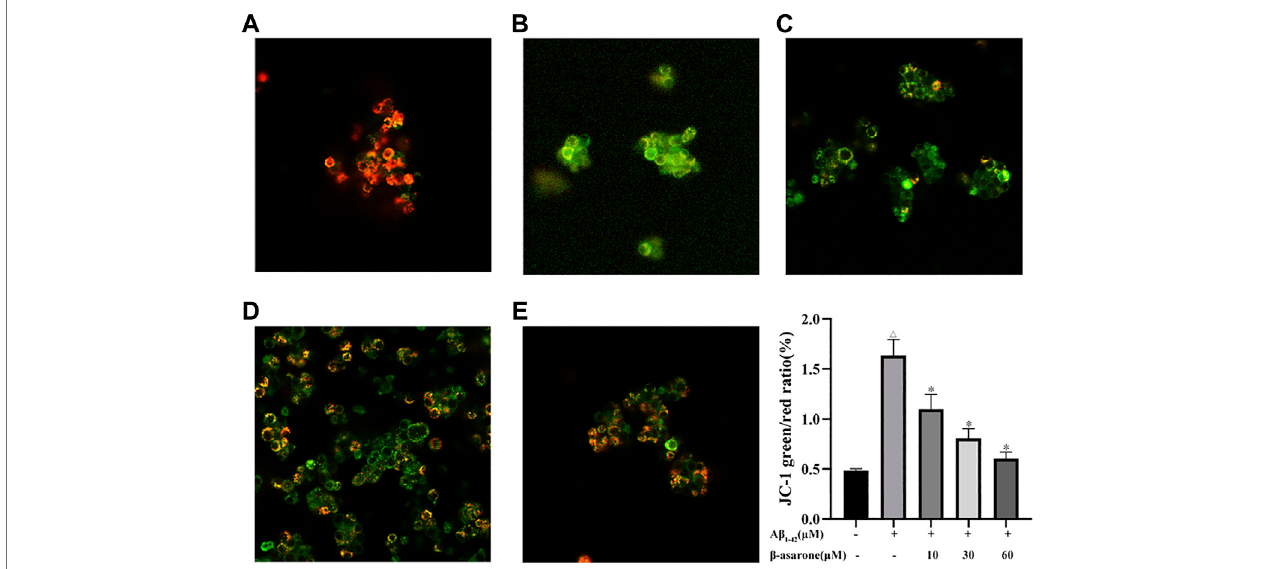
FIGURE 3 | Effect of β -asarone on A β 1 – 42 – induced mitochondrial membrane potential. PC12 cells were stained with JC-1 and observed under a fl uorescence microscope ( × 400). a , control group; b , A β 1 – 42 alone treatment group; c , A β 1 – 42 + β -asarone (10 μ M) group; d , A β 1 – 42 + β -asarone (30 μ M) group; e , A β 1 – 42 + β -asarone (60 μ M) group; △ p < 0.05 compared with the control group; * p < 0.05 compared with the A β 1 – 42 alone treatment group. The data were expressed as mean ± SD from three independent experiments.